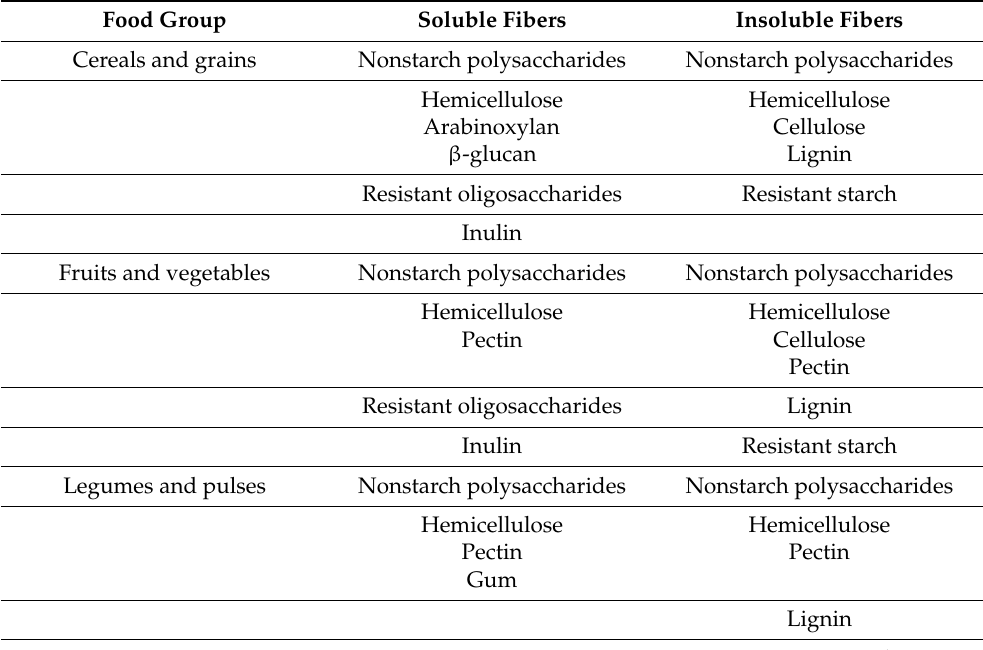
Table 2. Main food groups and fiber varieties according to